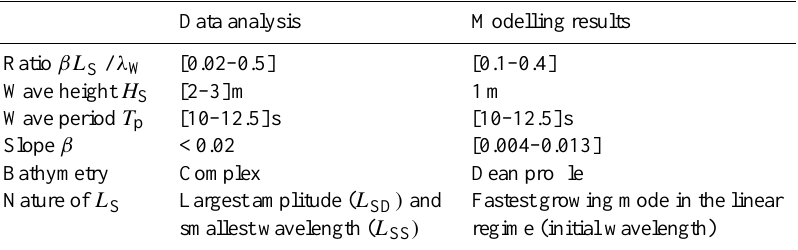
Table 1. Ratio βL S / λ W obtained from data analysis (this paper) and the modelling results (van den Berg et al., 2014), with the corresponding wave (for the data analysis: averaged over year 2012) and morphological